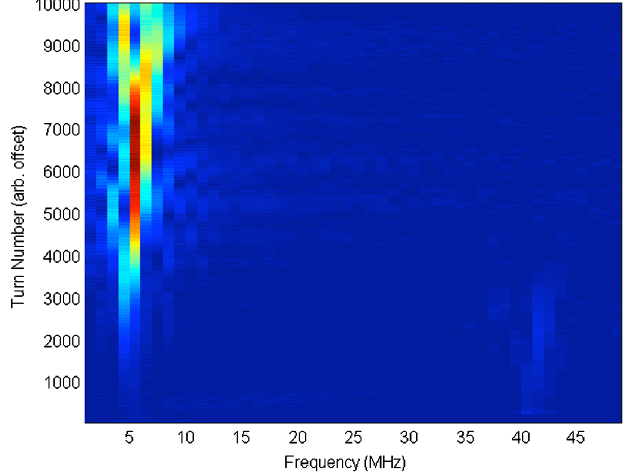
FIG. 7. Evolution of experimental turn-by-turn vertical har- monic spectrum of the extraction kicker